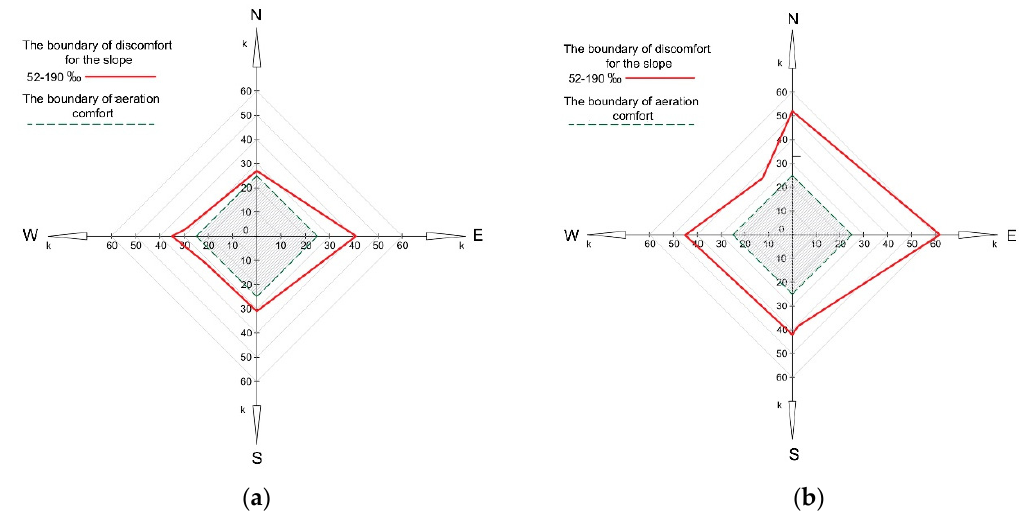
Figure 25. Petal diagrams showing the boundary of discomfort at gradients 52–190‰ and data on the share of discomfortable zones k: ( a ) perimeter morphotype, ( b ) ribbon morphotype.